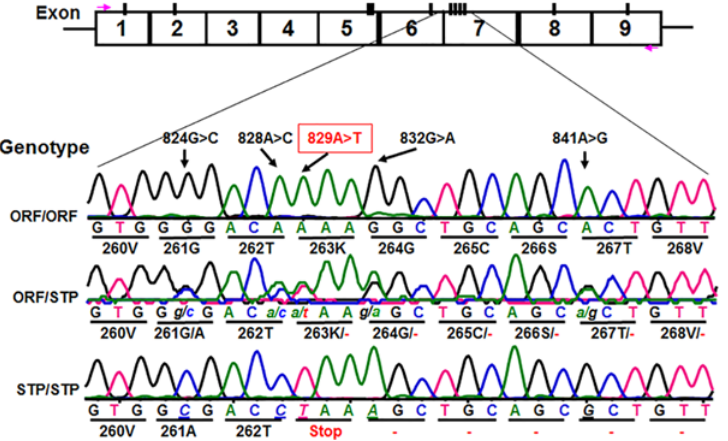
Fig 2. Identification of novel CD177 coding SNPs and SNP haplotypes. The CD177 cDNAs from 11 HNA-2 deficiency donors contain five novel cSNPs (824G > C, 828A > C, 829A > T, 832G > A, and 841A > G) that form a previously unidentified haplotype (824C/828C/829T/832A/841G). The CD177 cSNP 829A > T is a nonsense polymorphism that creates a translation stop codon at amino acid position 263 (Lysine ! Stop codon change) in CD177 open reading frame. The upper row of tracers is the haplotype containing 829A allele (designated as ORF or open reading frame allele) while the lower row tracer shows the haplotype containing 829T allele (designated as STP or stop codon allele). The middle tracer was from a heterozygous